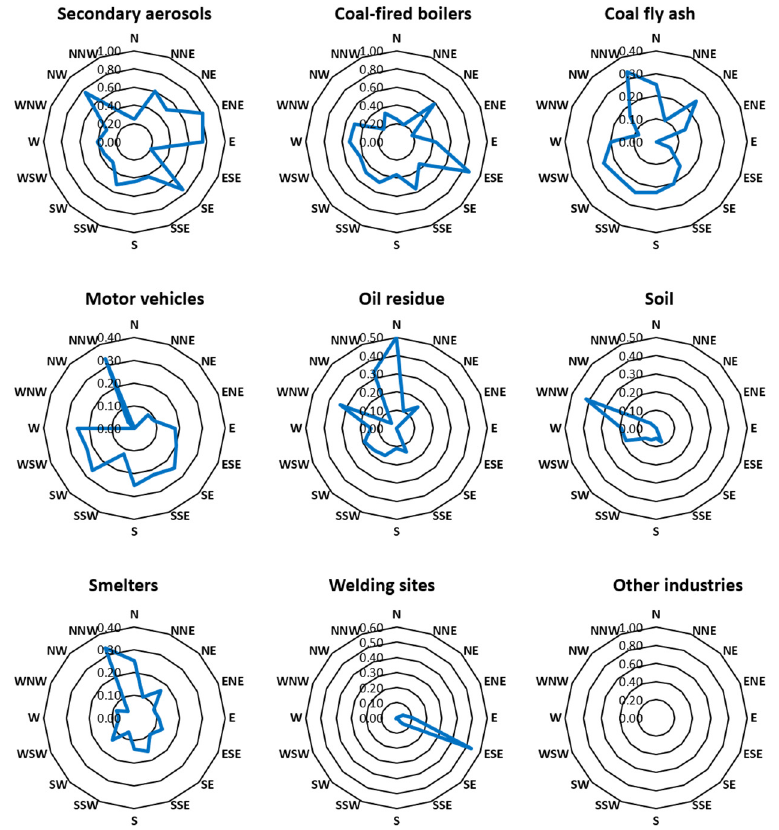
Figure 8. CPF plot for each source of PM 2.5 identified in the PMF analysis.